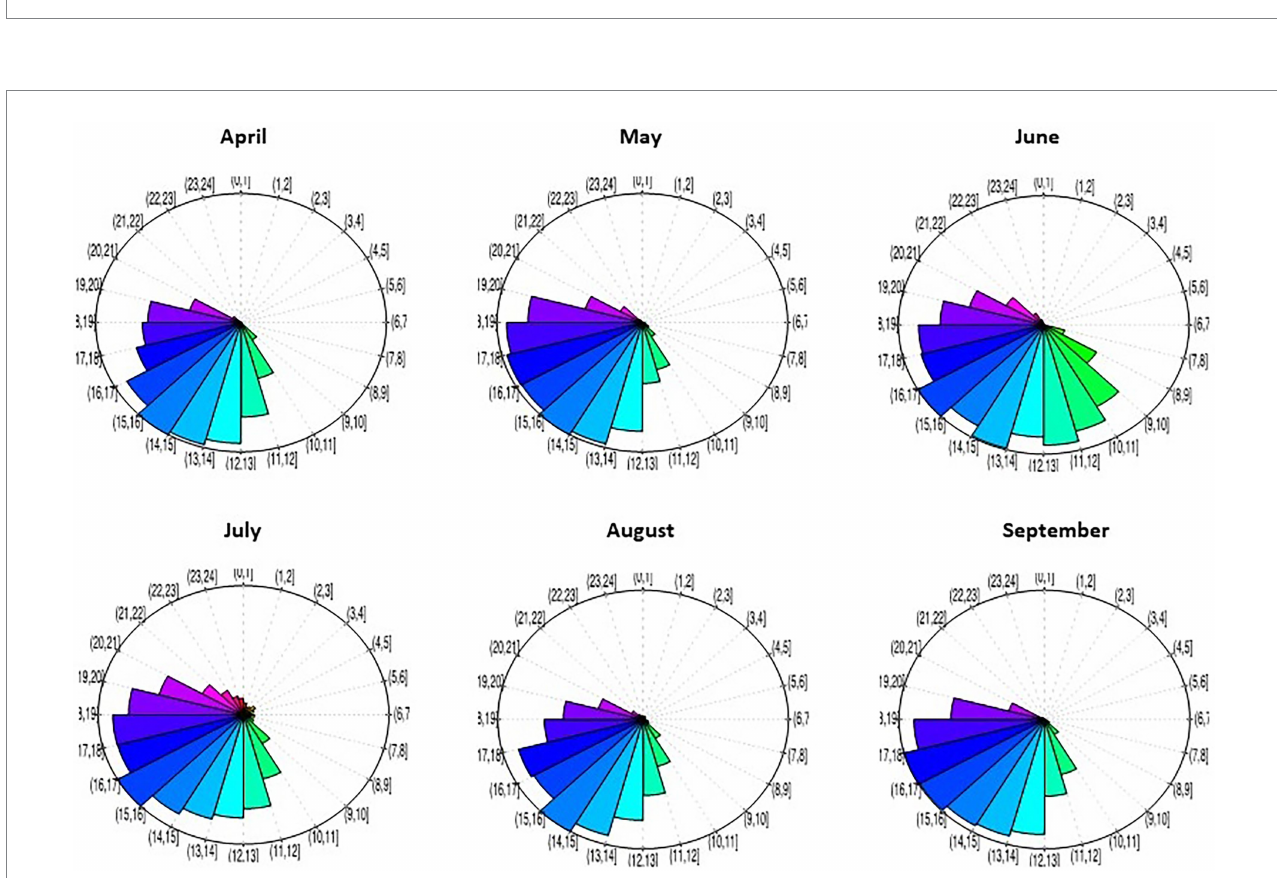
FIGURE 3 Honey bee exit activity from the hive by time of day. The circles depict the 24 h of a day during which we recorded trips of RFID transponder-labeled workers ( n = 1,330 bees in total introduced at the beginning of every month between April and September by cohort of 90–308 individuals). The circle shows the maximum exit activity recorded per hour in the month (baseline from which the exit rate at other hours was calculated). The hours are those recorded by the RFID device- embedded computer (Requier,